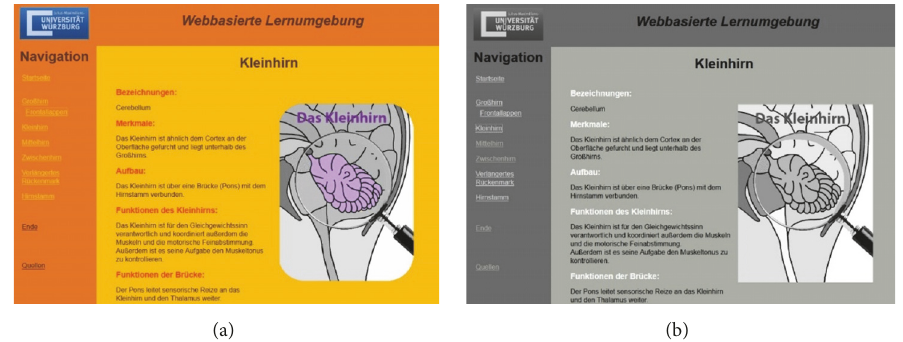
Figure 1: Screenshots of the two hypertext-based multimedia learning environments used in the experiment. (a) The multimedia learning environment designed to elicit positive affect by the use of bright colours and round shapes; (b) affectively neutral counterpart using achromatic colours and sharp